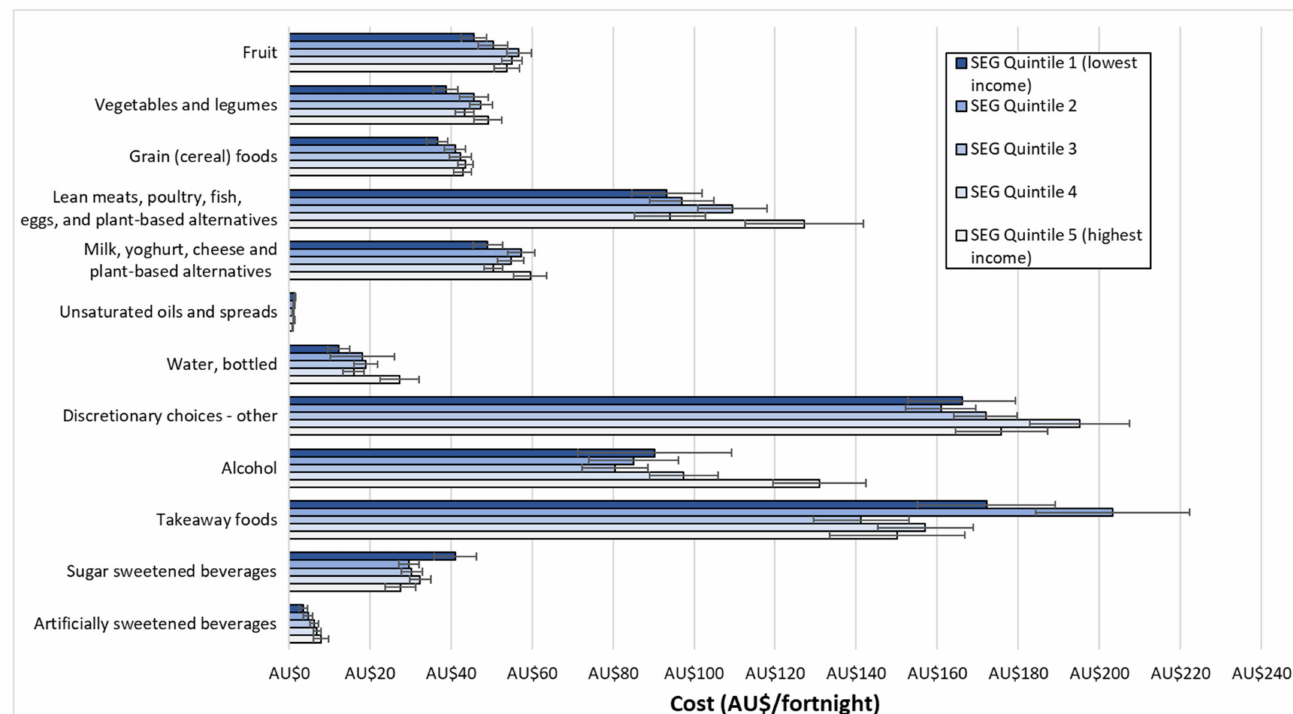
Figure 2. Habitual diet food category costs for each SEG for a reference household (two adults, two children). Error bars denote standard errors.